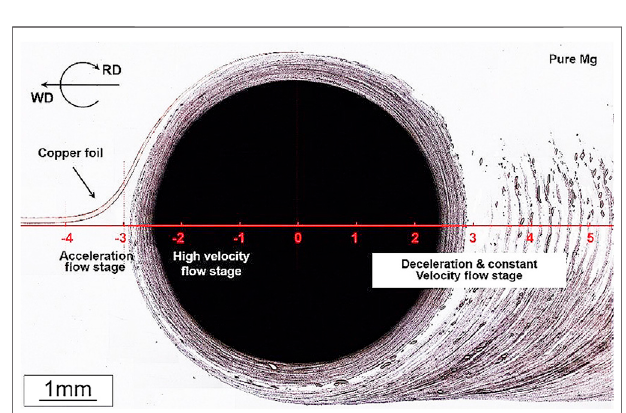
FIGURE 3 | Metallographic photo of the “ stop action ” of FSW (1,000 rpm, 200 mm/min).